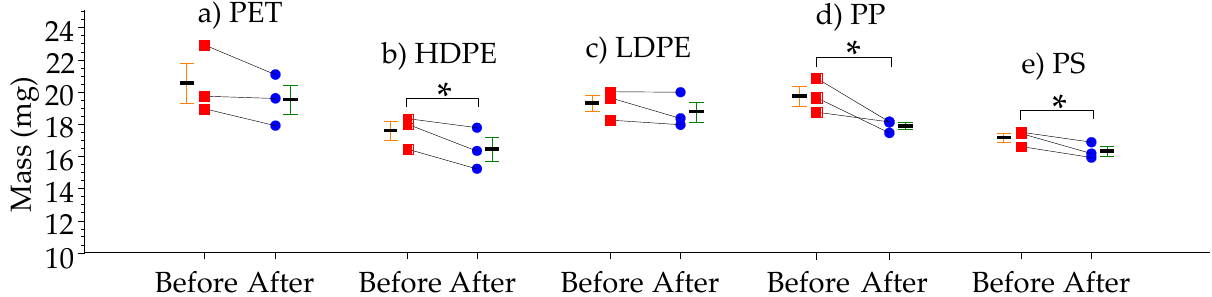
Figure 3. Mass change of five different types of model plastics and paired t -test analysis for each model microplastic sample of three repeats with 10% ( w / w ) potassium hydroxide (KOH) solution at V = 20 mL and T = 20 ◦ C for t = 24 h. The mean mass loss percentage (shown as short black bar) for ( a ) PET, ( b ) HDPE, ( c ) LDPE, ( d ) PP and ( e ) PS were 5.0, 6.7, 2.8, 9.3 and 5.0%, respectively. Error bars are standard deviation ± mean of experimental values. Solid points show the actual values of each datum, and the long thin black lines are the connection of the same samples before and after the treatment. * = p <